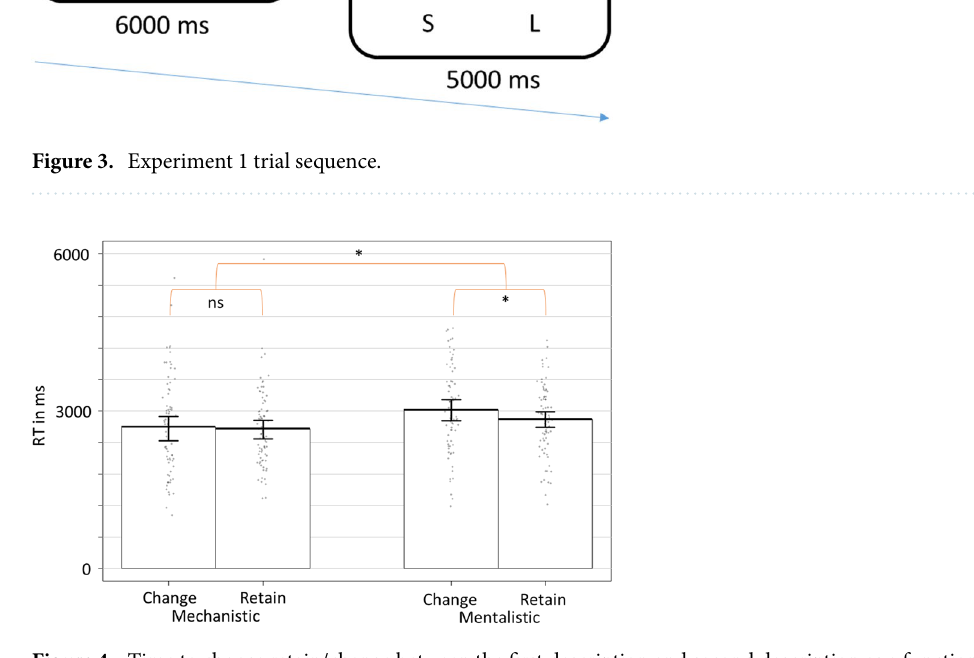
Figure 4. Time to choose retain/change between the first description and second description as a function of the description type (mechanistic vs mentalistic). * = p <